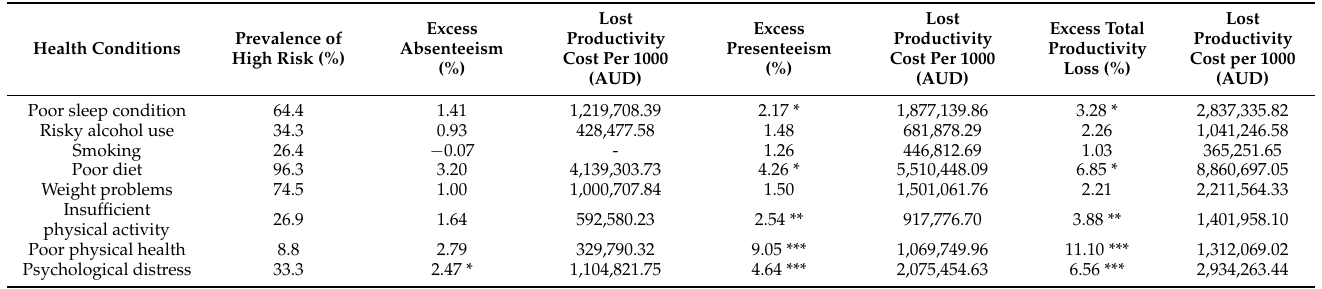
Table 6. Estimates of loss in productivity per year by health indicators per 1000 FIFO workers (N =